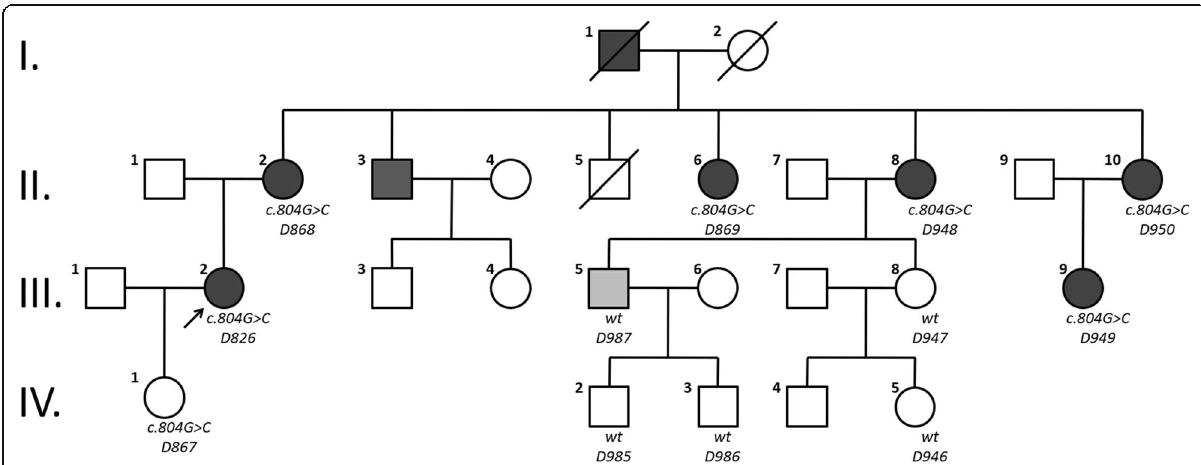
Fig. 1 Pedigree of the family depicting segregation of c.804G > C. Arrow indicates the proband where WES was performed. Squares indicate males, circles females. White symbols stand for unaffected family members, filled with black denote affected individuals, grey indicates unilateral hearing